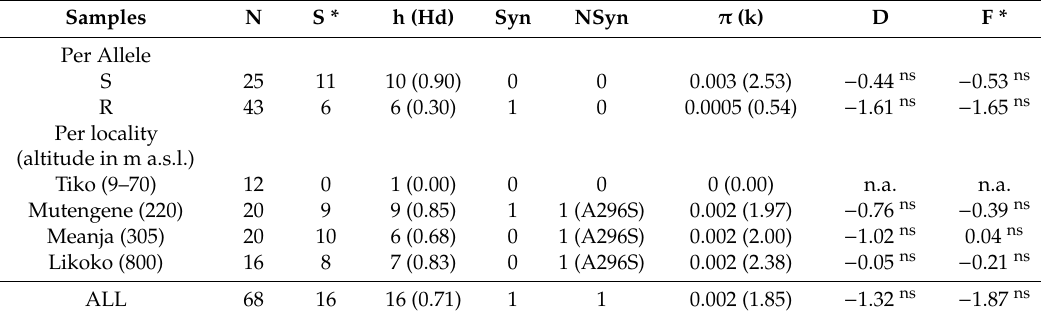
Table 2. Genetic variability parameters of Rdl full mutation.